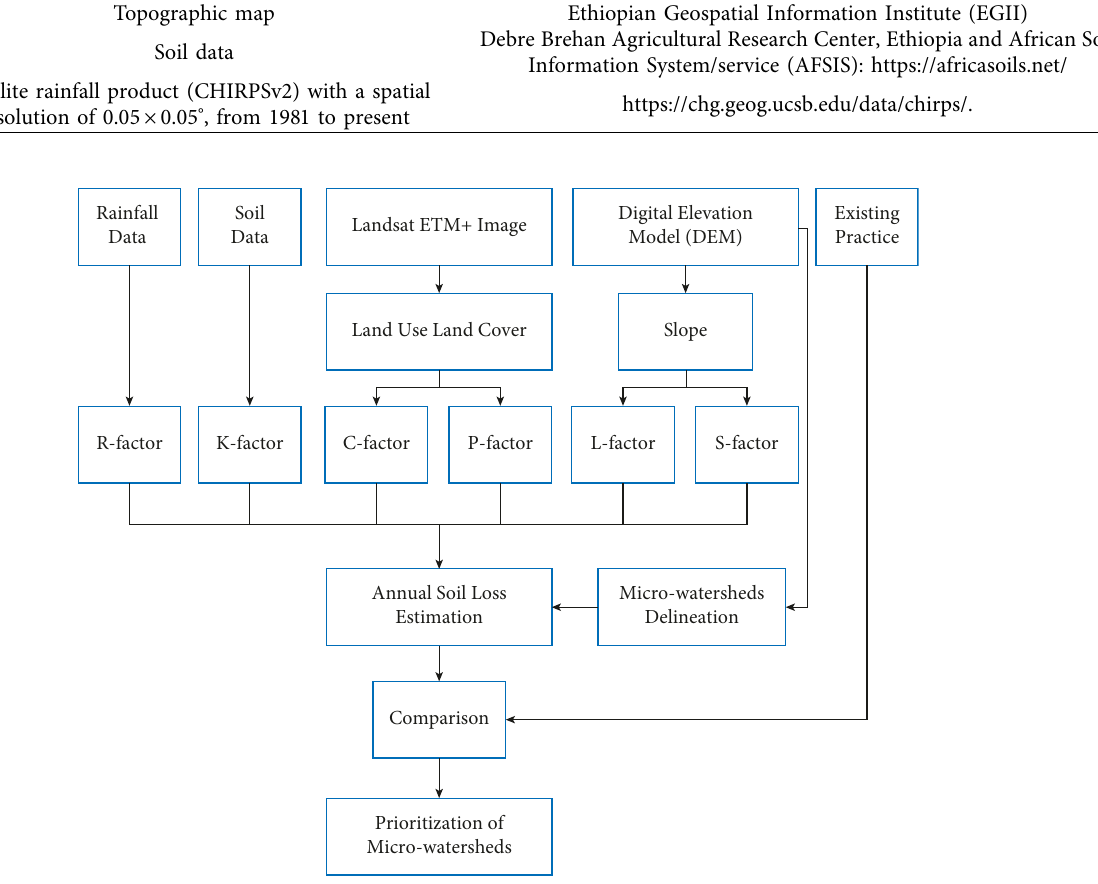
Figure 2: Overall framework of soil loss estimation and